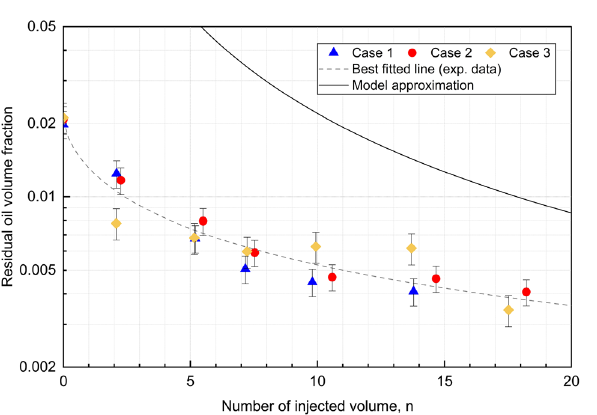
Figure 6. Pictogram of final THF solution in quartz cuvettes with different injected volume from Case #1 (left) and their UV–Vis spectra (right). The complete data set for UV–Vis spectra measurements (right) can be found as Supplementary Table S3 online.